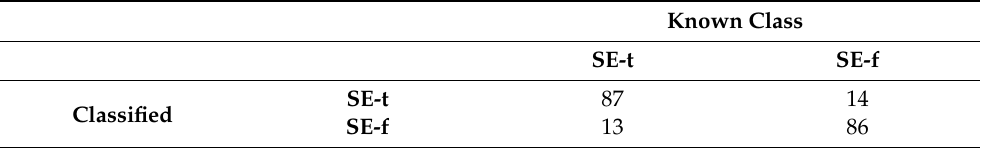
Table 3. Confusion matrix for cuttlefishes: SE-t (thawed); SE-f (fresh). Performance: F 1 = 0.846. All values are expressed in percentage.